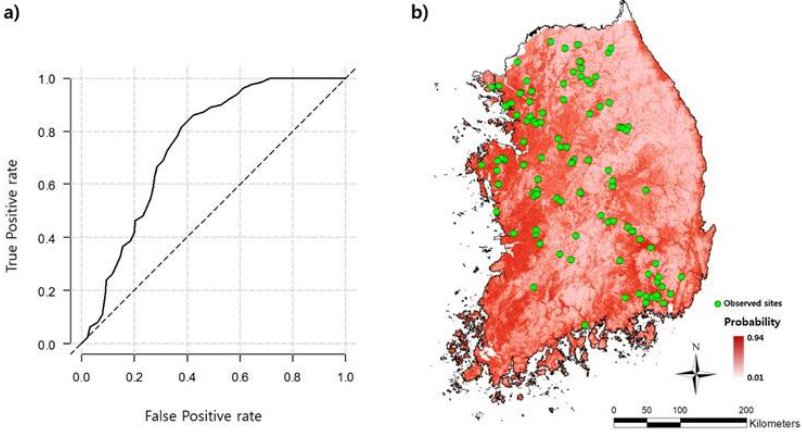
Figure 6. Prediction of potential distribution area of Metcalfa pruinosa with the random forest (RF) model. ( a ) Mean receiver operating characteristic (ROC) curve of the random forest (RF) model with 10 replications and ( b ) predicted potential distribution with different occurrence probability and actual observed sites with green circles.